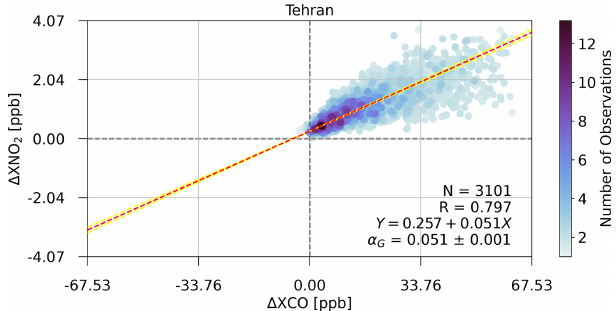
onto anomalies of X CO Figure 5. Regression of anomalies of X NO 2 over Tehran using TROPOMI data from June–August 2018. The dashed red line indicates the estimated enhancement ratio, while the yellow lines represent ± 2 σ uncertainties in the ratio. Each data point represents a single observation and is assigned a colour to in- dicate the density of points by binning the observations into 100 bins across each axis and counting the number of points in the bin in which the observation resides. N is the total number of points included in the regression, R is the correlation coefficient, Y is the equation of best fit, and α G is the slope and 2 σ uncertainty deter- mined by